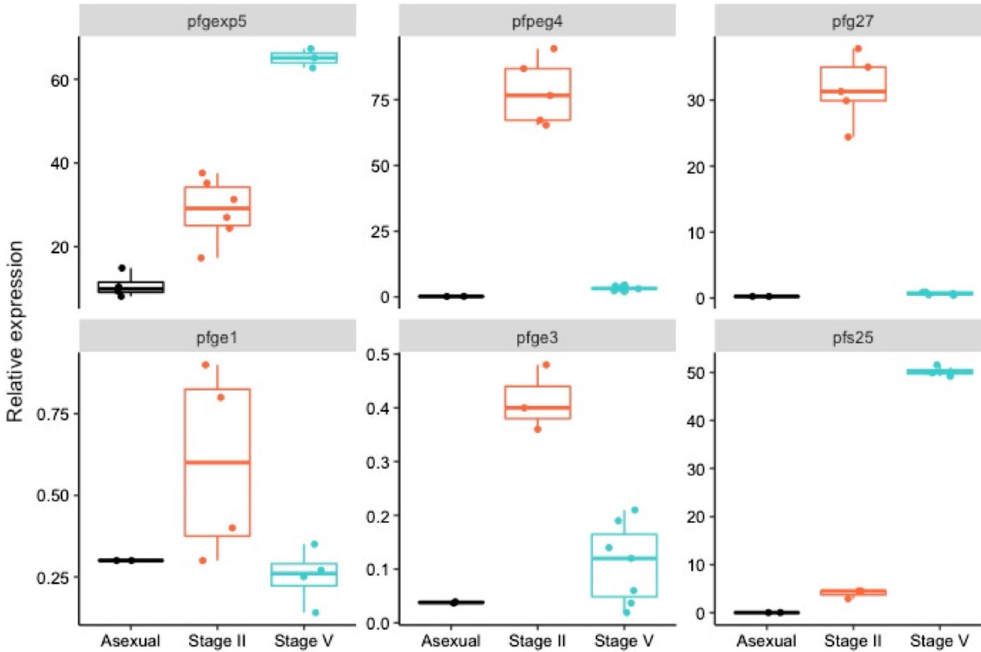
Figure 1. Validation of early gametocyte markers. Figure shows fold change (y axis) in expression of early ( pfpeg4 , pfg27 , pfge1 , pfge3 and pfgexp5 ) and late ( pfs25 ) markers relative to the reference gene ( pf40S ) expression in parasites obtained from in vitro culture at different parasite developmental stages. Points represents actual data points, boxplots represent median, first and third quartiles. Error bars represent the minimum and the maximum fold